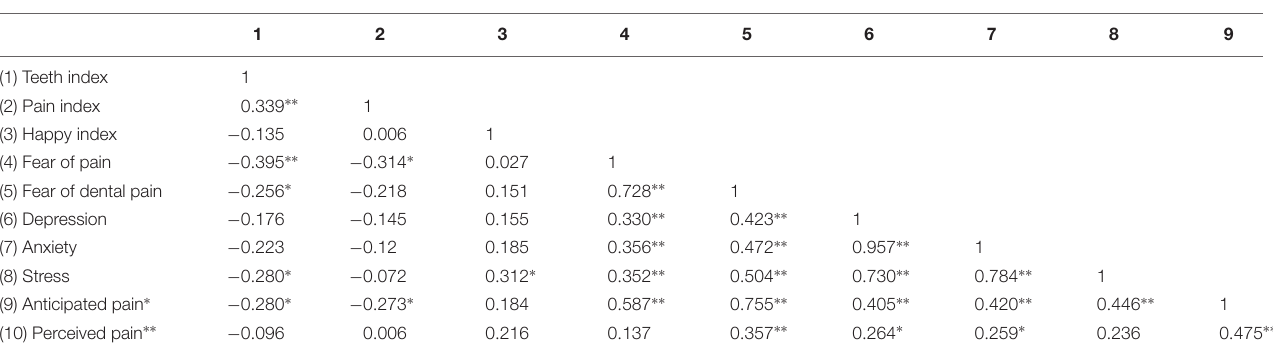
TABLE 4 | Correlations between pain-related variables and DASS scales among pain expectancy